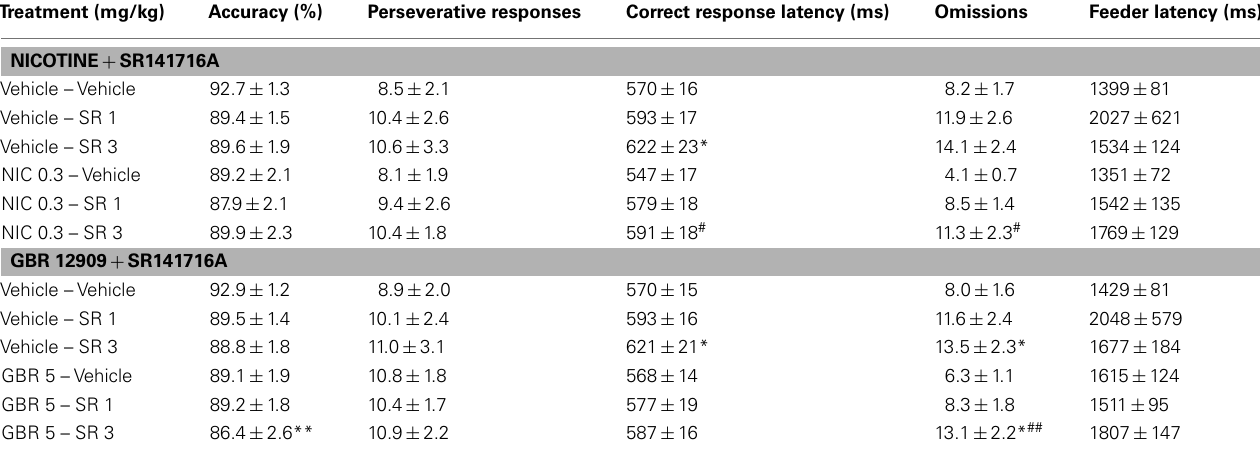
Table 1 | Effects of the psychostimulant nicotine (NIC) and the selective dopamine transporter inhibitor GBR 12909 (GBR), alone and in combination with the selective CB1 receptor antagonist SR141716A (SR) on measures of attentional function, compulsivity, and motivation in the